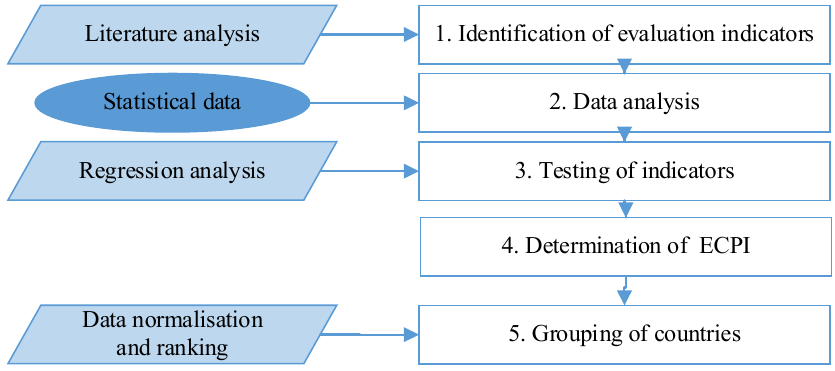
Fig. 1. Main steps of the research and used